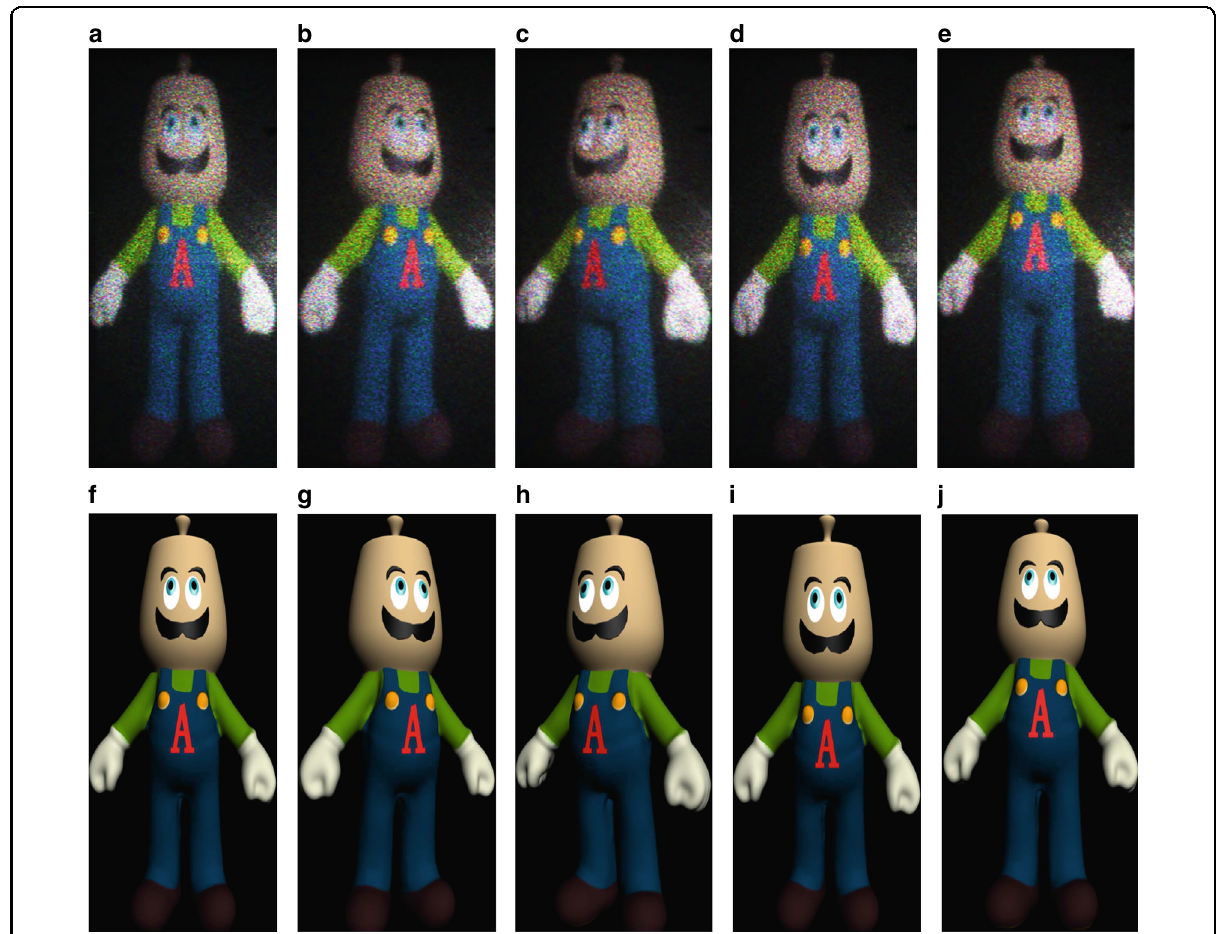
Fig. 7 Reconstructed holographic images of a 3D teapot man using dynamic holobricks at different viewing angles. a Results of the 0° position, b , c images of − 20° and + 20° in the horizontal direction, d , e displaying at − 3° and + 3° in the vertical direction, and f – j original images at different viewing angles at 0°, − 20°(horizontal), + 20°(horizontal), − 3° (vertical), + 3° (vertical),